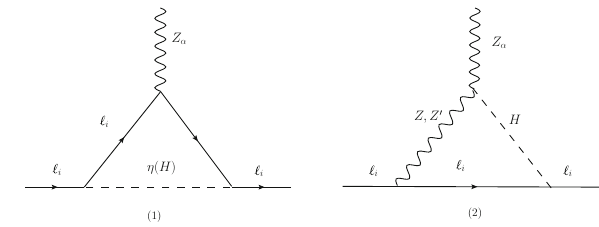
Fig. 2 Feynman diagrams that contributes to the AWMDM of a lepton in the scalar sector of the SLHM at the one-loop level. We do not show the diagram obtained by exchanging the Z ( Z (cid:4) ) gauge boson and the Higgs boson in diagram ( 2 ). The new contributions of the SM Higgs boson contributions are due to the diagram with the Z (cid:4) gauge boson and also to corrections to the SM vertices H (cid:6)(cid:6) and H Z